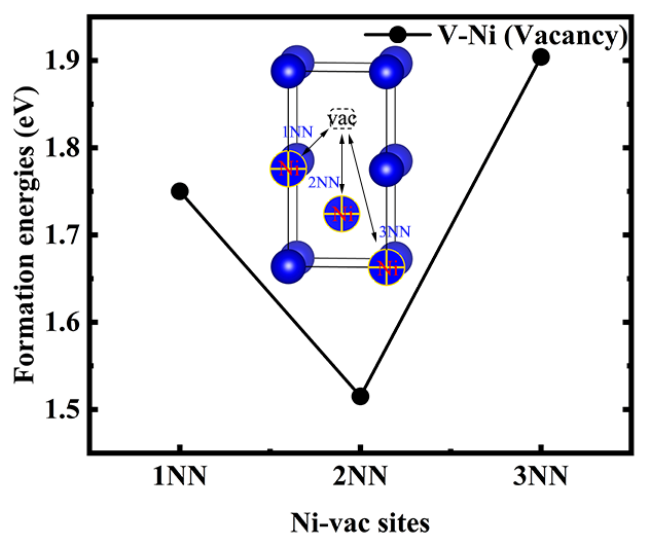
Figure 5. Monovacancy formation energy in V–Ni solid solution alloy.